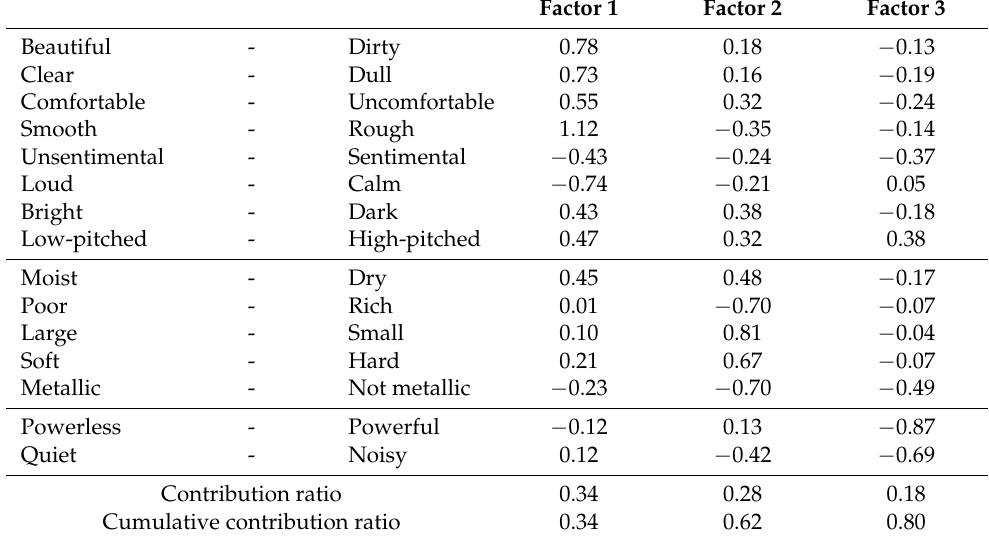
Table 2. Results of the factor loadings and the contribution ratio of the 15 adjectives for each factor of factors 1, 2 and 3 obtained from the factor analysis. For each adjective, the factor with the highest factor loading is marked with a yellow marker. The first, second and third factors are named the “comfort factor”, “timbre factor” and “power factor”, respectively. The contribution rate of the comfort factor was the largest at